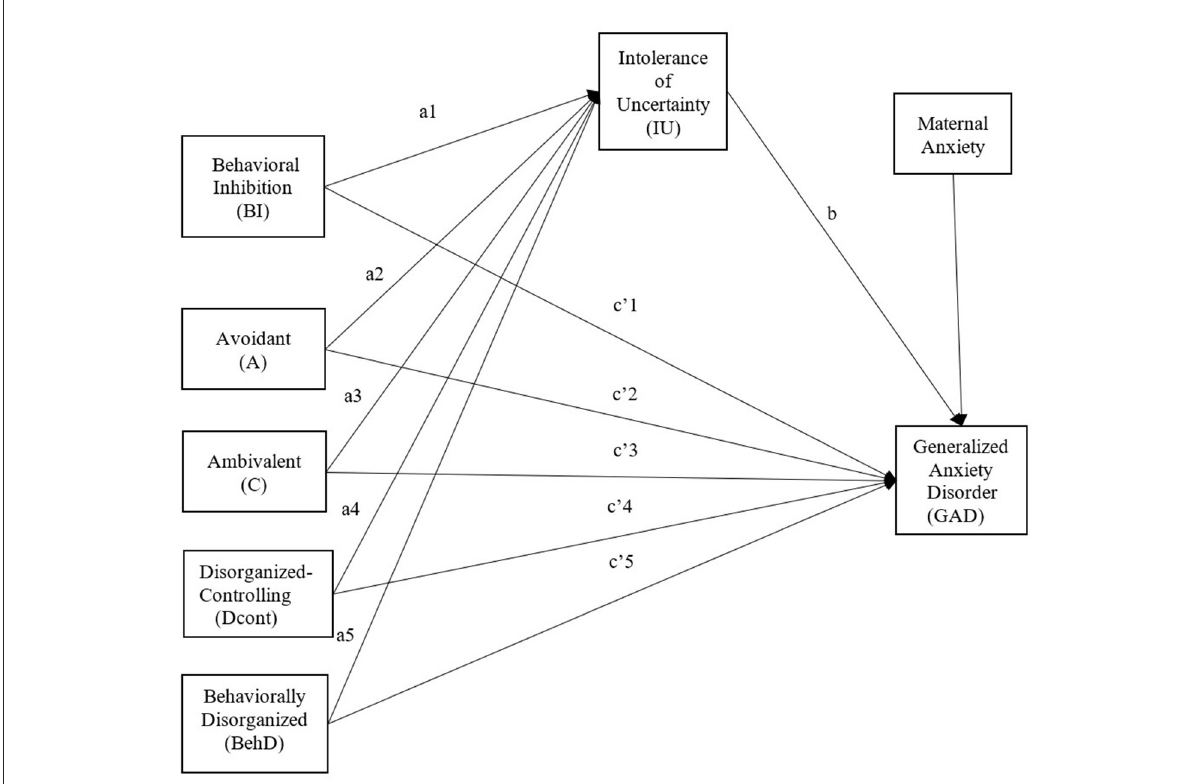
FIGURE1 Tested model of direct and indirect effects of behavioral inhibition and attachment on GAD symptoms through IU, controlling for maternal anxiety.